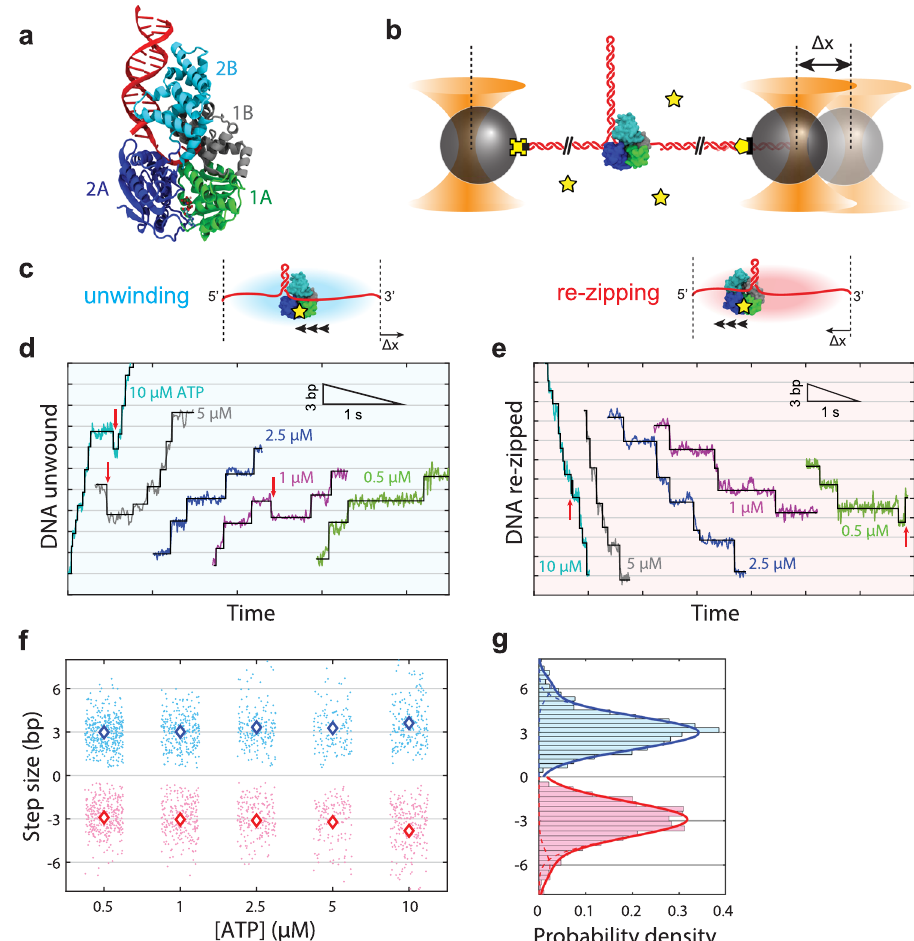
Fig. 1 UvrD helicase unwinds and re-zips DNA in steps averaging 3 bp. a Crystal structure of UvrD bound to ss/dsDNA junction (PDB accession number 2IS2) with color-coded subdomains 1A, 2A, 1B, and 2B. b Schematic of optical trapping assay. An 89-bp long DNA hairpin stem fl anked by two 1.5-kb dsDNA handles is tethered between two optically trapped polystyrene beads by biotin-streptavidin (yellow cross-black square) and digoxigenin-anti- digoxigenin (yellow pentagon-black rectangle) linkages. A 10-dT loading site allows a single UvrD to bind. Addition of ATP (yellow star) after loading UvrD initiates helicase unwinding in a 3 ′ to 5 ′ direction, detected as a change in tether extension, Δ x , at constant force. c Hairpin unwinding (blue) leads to an increase in extension from the released ssDNA at constant force. Re-zipping (red), mediated by UvrD strand-switching and translocating on the opposite strand of the hairpin stem allowing the DNA to re-zip, leads to a decrease in extension at constant force. d , e Representative data traces of UvrD stepping behavior during unwinding ( d ) and re-zipping ( e ) across ATP concentrations (color coded as shown) and forces (11 – 14 pN). The black lines represent fi ts to a statistical step detection algorithm. Red arrows indicate backsteps in unwinding and re-zipping traces. f Scatter plot of individual unwinding (blue points) and re-zipping (red points) step size measurements at each ATP concentration, and plot of the average step size (blue and red diamonds). Total number of steps displayed: N = 394, 287, 191, 134, 200 (unwinding) and 338, 256, 192, 138, 237 (re-zipping) from 25, 16, 12, 12, 12 traces at [ATP] = 0.5, 1, 2.5, 5, 10 μ M, respectively. Error bars denoting the s.e.m. are smaller than the diamond symbol size. g Histogram of unwinding (blue) and re-zipping (red) step sizes over all ATP concentrations, with fi ts to double-Gaussian distributions (solid lines; dotted lines represent individual single-Gaussian components). Total number of steps in histogram: N = 1206 (unwinding), 1161 (re-zipping) from 77 traces across ATP. Source data are provided as a Source Data fi DNA hairpin consisting of an 89-bp stem capped with a dT the ATP channel to initiate unwinding. We calculated the num- tetraloop and fl anked by two 1.5-kb dsDNA handles between two ber of base pairs unwound over time from the change in exten- optically trapped polystyrene beads (Fig. 1b; see “ Methods ” ). A sion of the tether as UvrD released the newly formed ssDNA, (dT) 10 ssDNA loading site on the 3 ′ side of the hairpin was used converting each 2 nucleotides (nt) released into 1 bp unwound (see “ Methods ” ). Data were collected at a constant tension for helicase binding; the 10-nt loading site size guaranteed that a through active force feedback over a range of forces (9 – 15 pN) maximum of one UvrD bound to the DNA 48 . All experiments were performed in a laminar fl ow sample chamber 49 where two below the mechanical unfolding force (~16 pN) of the hairpin adjacent buffer channels merged to form a smooth interface, (Supplementary Fig. 2), and over a range of ATP concentrations which allowed for different components to be contained in each (0.5 – 10 μ M). A typical unwinding trace is shown in Supple- channel (Supplementary Fig. 1; see “ Methods ” ). In a typical mentary Fig. 1. In line with previous single-molecule studies 28 , monomeric UvrD unwinds short lengths (~20 bp at 10 μ M ATP) experiment, a single DNA hairpin tether was formed in situ in the of dsDNA in short, repetitive bursts. Unwinding is interrupted by bottom channel containing ATP but no UvrD, moved to the periods of gradual DNA re-zipping, which correspond to UvrD upper channel containing UvrD but no ATP for a 10 – 30 s translocating on the opposing strand of the hairpin in a 3 ′ to 5 ′ incubation period to load the helicase, and fi nally moved back to